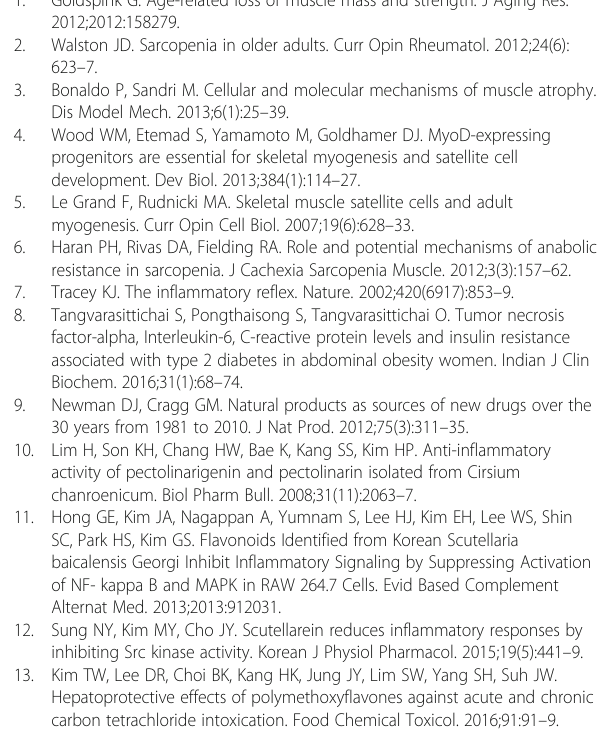
Fig. 4 Schematic diagram showing the predicted sinensetin (SIN) pathway for